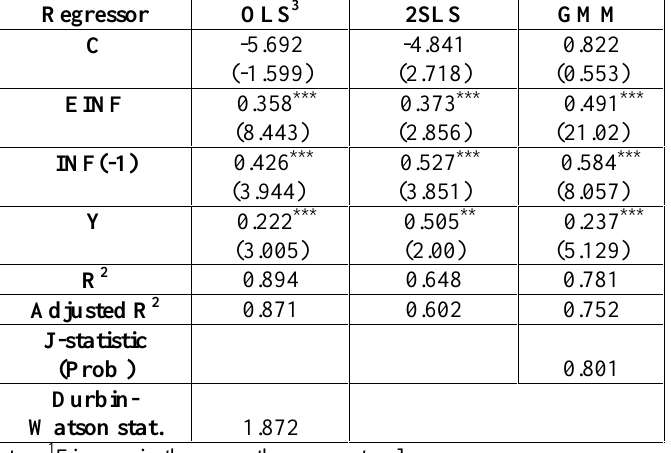
Table 5: Reduced form Estimates of the Hybrid